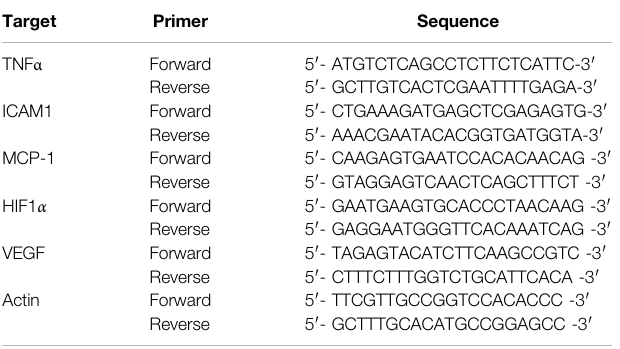
TABLE 1 | List of primers for real-time